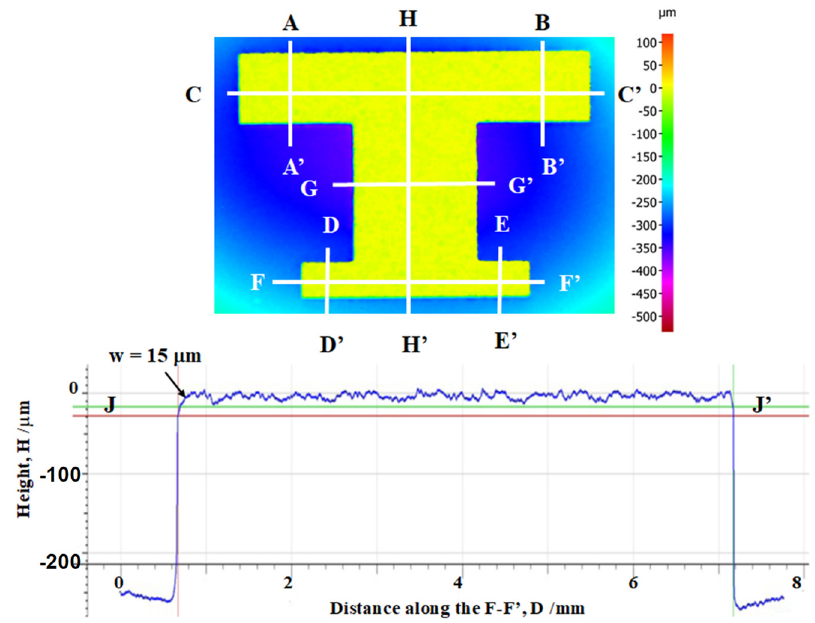
Figure 9. Three-dimensional profile of T-shaped punch head with its cross-sectional view along the line F–F’.